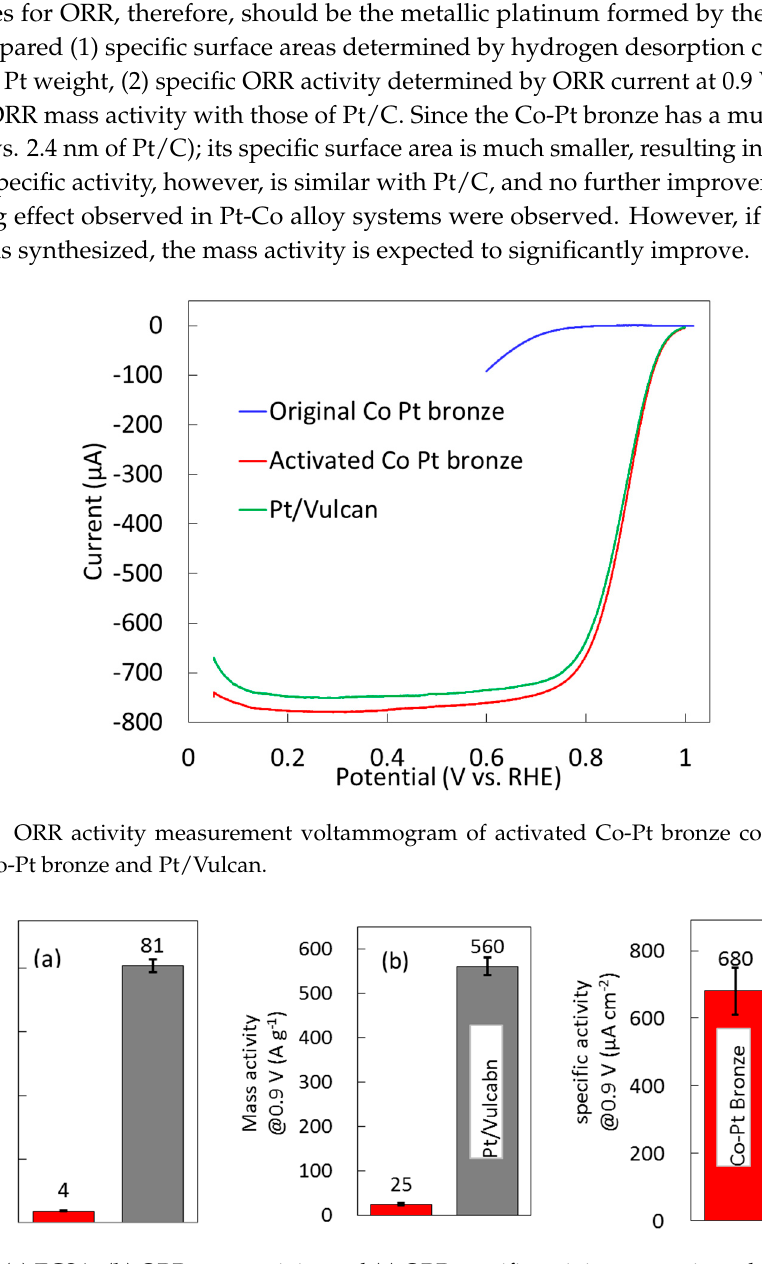
Figure 12. ( a ) ECSA; ( b ) ORR mass activity and ( c ) ORR specific activity comparisons between Co-Pt bronze and Pt/Vulcan.